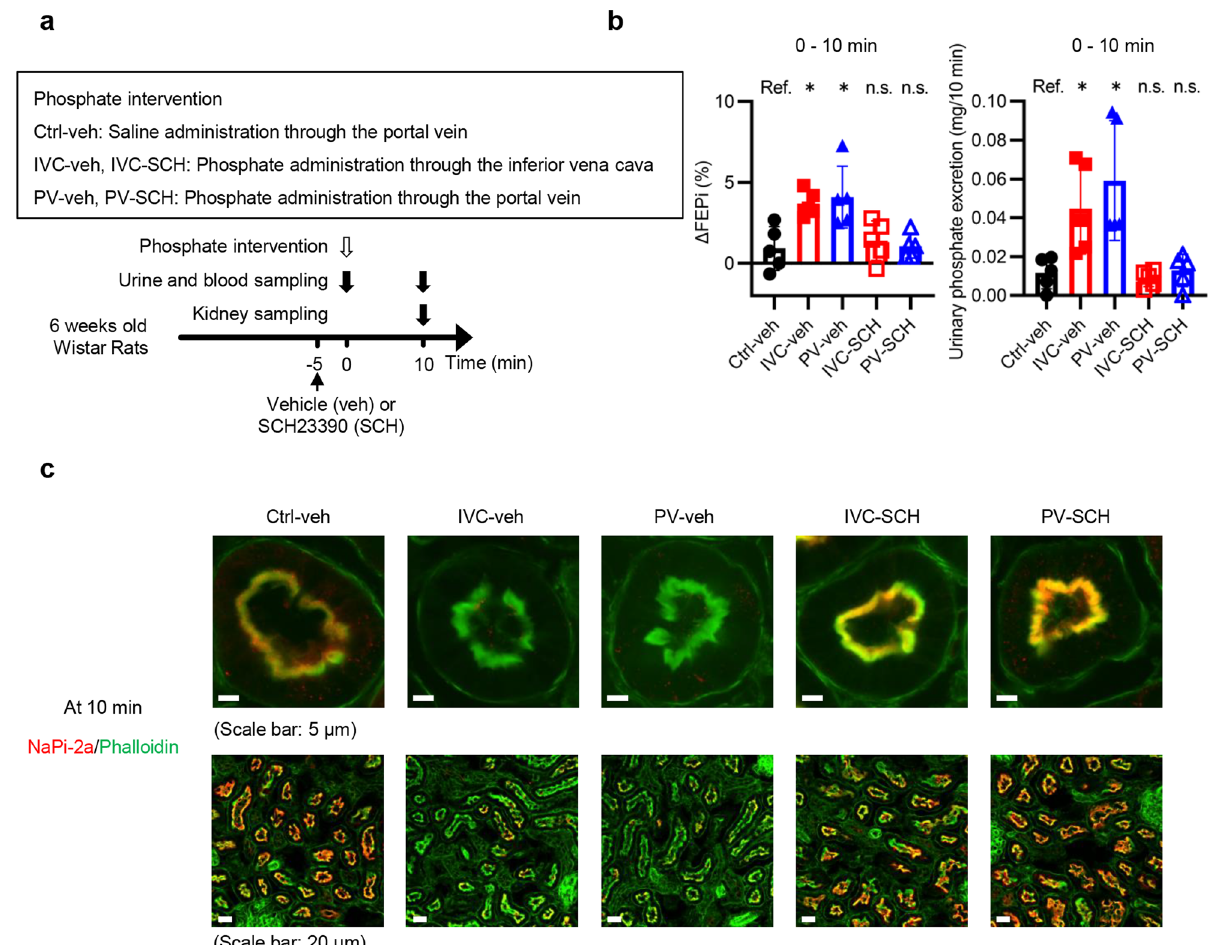
Figure 5. Rats in the IVC and PV groups increased FEPi and phosphaturia within the first 10 min in a dopamine D1-like receptor-dependent manner. ( a ) Experimental design for ( b ) and ( c ). Rats pretreated with SCH23390, a D1-like dopamine receptor antagonist, were randomly divided into two groups, IVC-SCH and PV-SCH. Vehicle-pretreated (normal saline) rats were randomly divided into three groups, Ctrl-veh, IVC-veh, and PV-veh. Five minutes after these pretreatments, rats in groups with Ctrl in the group name, rats in groups with IVC in the group name, and rats in groups with PV in the group name were subjected to phosphate interventions similarly to the rats in the Ctrl, IVC, and PV groups, respectively. ( b ) ΔFEPi between 0 and 10 min and urinary phosphate excretion during the 10-min period (n = 5 rats per group). ( c ) Representative immunofluorescence images of renal PTECs stained with phalloidin (green) and NaPi-2a (red) at 10 min. The upper and the lower images in each group are the immunofluorescence images with higher and lower magnification, respectively (scale bars: 5 µm or 20 µm). The results are presented as the means ± SDs, n.s.: not significant, Ref.: reference. * P < 0.05 based on Dunnett’s test in ( b two-tailed Student’s t- test) (Fig. 2b). We evaluated the uptake of 32 P in various organs in the IVC- 32 P and PV- 32 P groups at 10 min, in addition to the evaluation at 5 min in Fig. 3b (Supplementary Fig. S7 online). The 32 P levels of the liver of the IVC- 32 P group at 10 min were significantly higher than those at 5 min. Moreover, the difference in 32 P levels in the liver between the IVC- 32 P and PV- 32 P groups at 5 min disappeared at 10 min. The other organs showed no change or decline in the 32 P levels from 5 to 10 min. Phosphorylation of endothelial nitric oxide synthase (eNOS) and levels of phosphate incorpo‑ ration to CPPs were suppressed in the PV group. We examined the effects of the temporarily elevated serum phosphate concentrations in the IVC group by assessing eNOS phosphorylation (Thr495), which is asso- ciated with endothelial dysfunction 20 . Western blot analyses of the aortic tissues collected at 20 min showed that phosphorylation of eNOS increased in the IVC group but not in the PV group (Fig. 6a,b). We also examined levels of phosphate incorporation into CPPs. BNX rats were randomly divided into Ctrl-BNX, IVC- 32 P-BNX, and PV- 32 P-BNX groups, and then similarly received phosphate interventions to the Ctrl, IVC- 32 P, and PV- 32 P groups (Fig. 6c,d). The levels of 32 P in the CPPs at 10 min from the IVC- 32 P-BNX group were significantly higher than those from the PV- 32 P-BNX group.